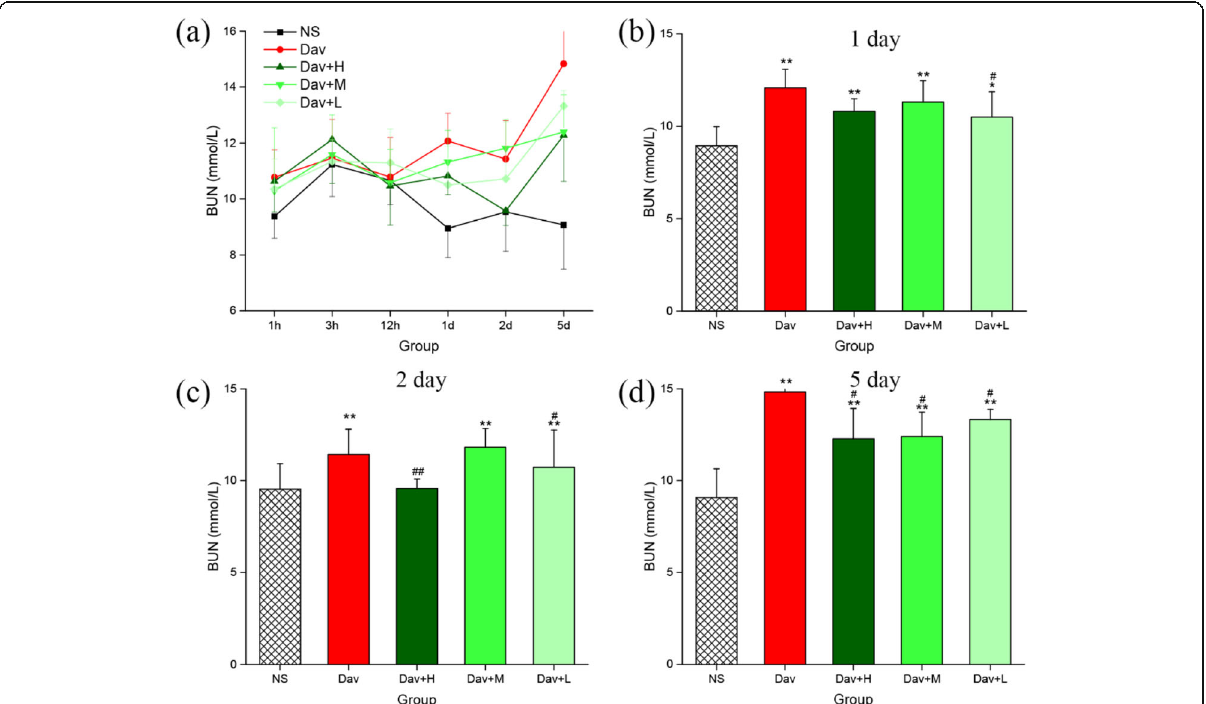
Fig. 6 Effects of Phellodendri Chinensis Cortex Carbonisata - carbon dots (PCCC-CDs) on blood urea nitrogen (BUN). a BUN concentration changes in 1 h, 3 h, 12 h, 1 day, 2 day and 5 day. The levels of BUN in ( b ) 1 day ( c ) 2 day ( d ) 5 day. Mouse were treated with normal saline (NS), D.acutus venom (Dav, 1 mg/kg) and high- (H), medium- (M) and low (L) doses of PCCC-CDs + Dav (1 mg/kg). Data are represented as mean ± SD of six animals of each group. * p < 0.05 and ** p < 0.01 compared with control group treated with NS. # p < 0.05 compared with Dav